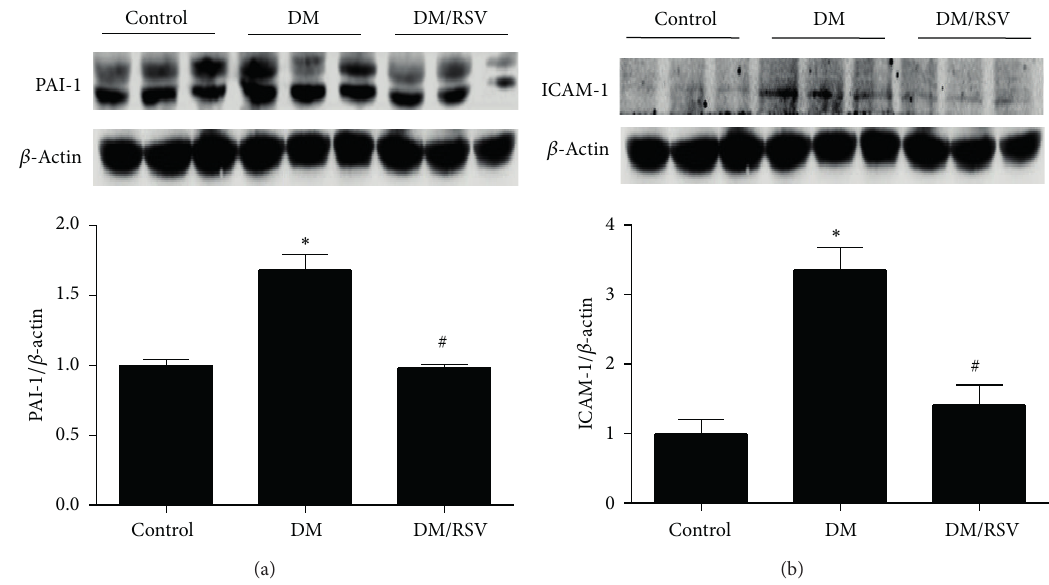
Figure 5: Resveratrol (RSV) protected mice from diabetes-induced kidney inflammation. Western blot analysis was carried out to measure the protein levels of plasminogen activator inhibitor (PAI-1) (a) and intercellular adhesion molecule-1 (ICAM-1) (b). Results represent as mean ± SD. ∗ 𝑃 < 0.05 compared with control group, # 𝑃 < 0.05 compared with diabetes mellitus (DM)